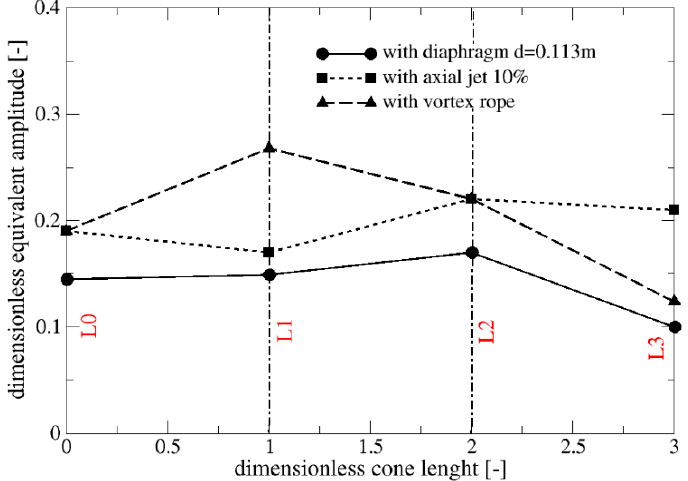
Figure 9. Comparison of the dimensionless equivalent amplitudes obtained for following cases: swirling flow with vortex rope (long dashed line), axial water jet method with 10% discharge (dashed line) and the diaphragm control method with shutter area of 50% (d = 0.113 m) (solid line).